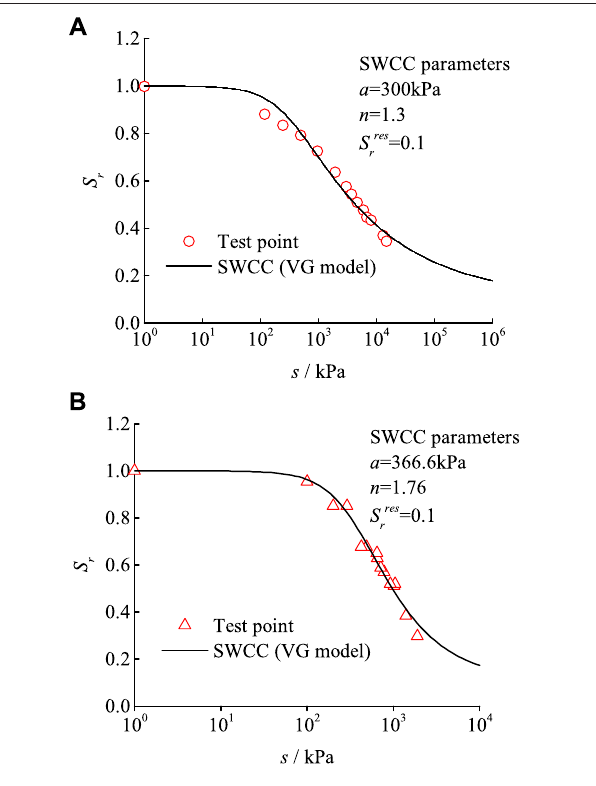
FIGURE 7 | SWCC of clays: (A) Madrid clay and (B) kaolin